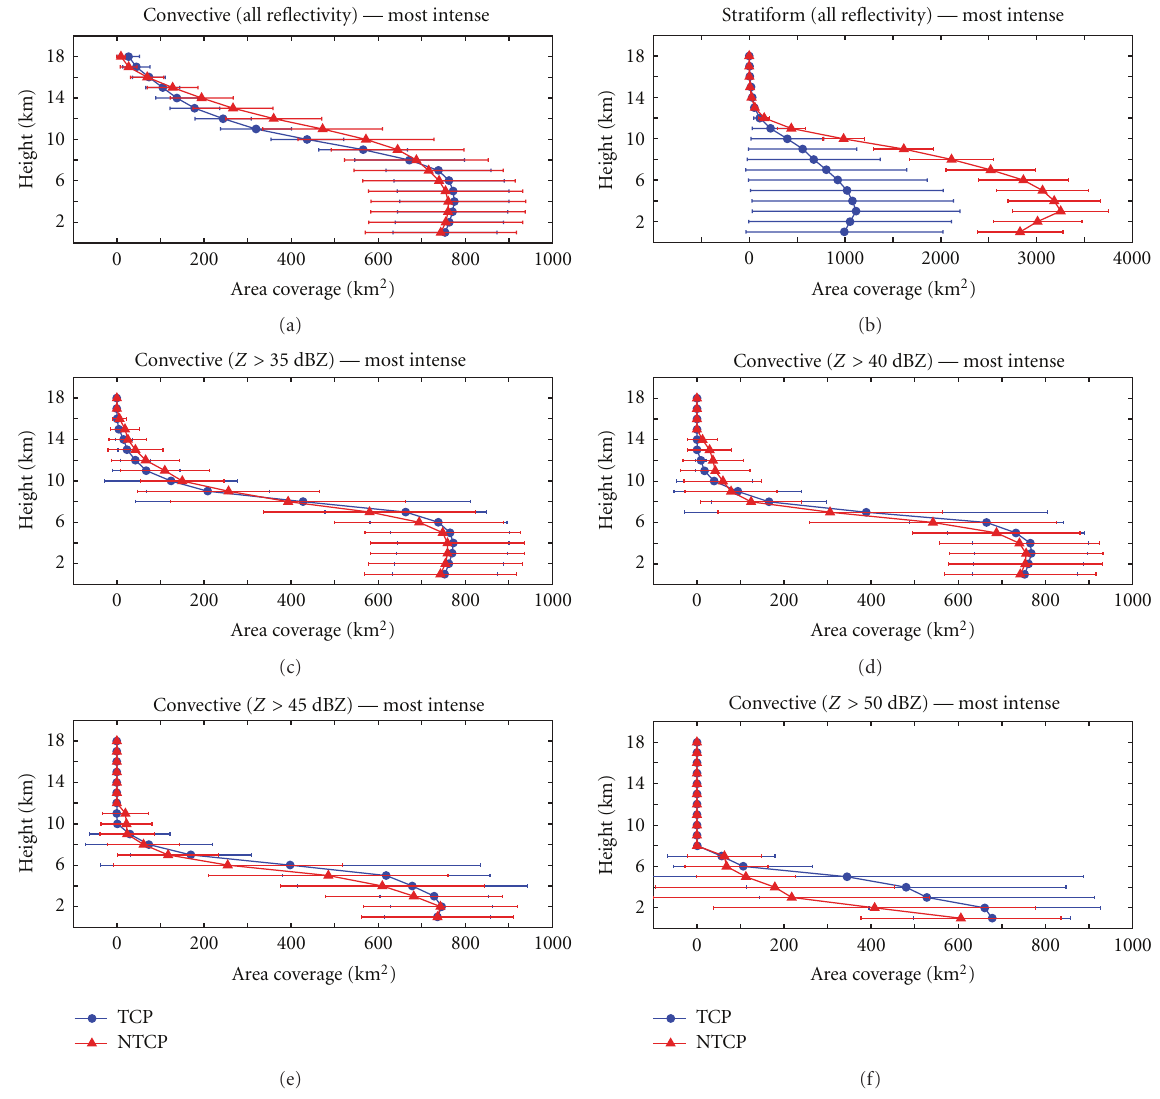
Figure 12: Coverage areas for the various precipitation types are shown in (a) convective regime with all reflectivity values, (b) stratiform, (c) convective with reflectivity greater than 35dBZ, (d) convective with reflectivity greater than 40dBZ, (e) convective with reflectivity greater than 45dBZ, and (f) convective with reflectivity greater than 50 dBZ. The blue line represents the mean TCP case and the red indicates the mean NTCP case. Error bars are provided and represent the 95% significance based on a Student’s t